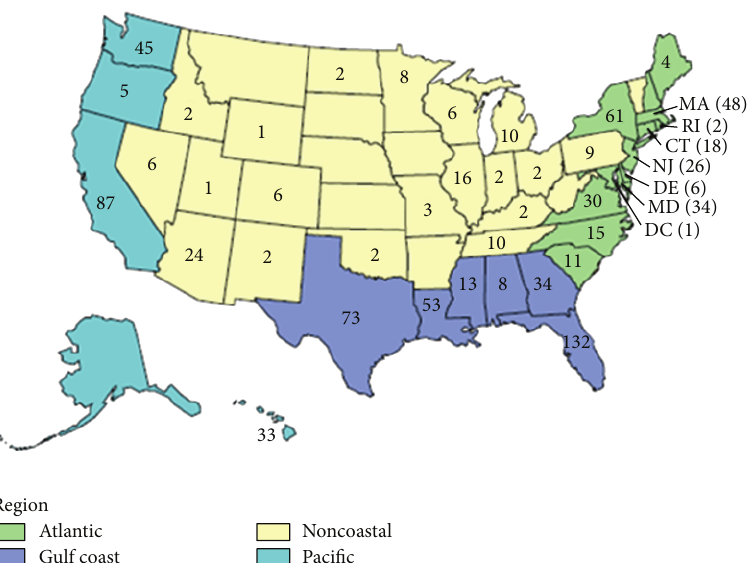
Figure 1: Geographic distribution of Vibrio infections in the United States in 2011, also taken directly from the 2011 COVIS report published on the CDC website